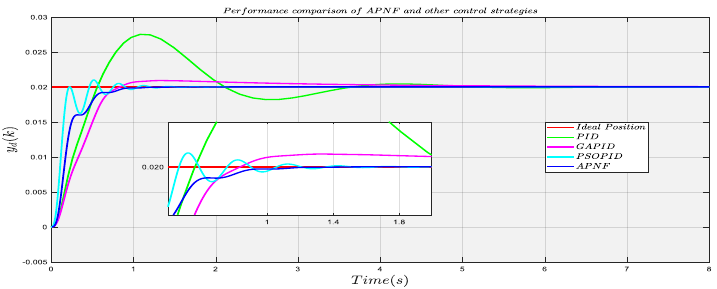
Figure 8. Response performance comparison curve of the four control systems.